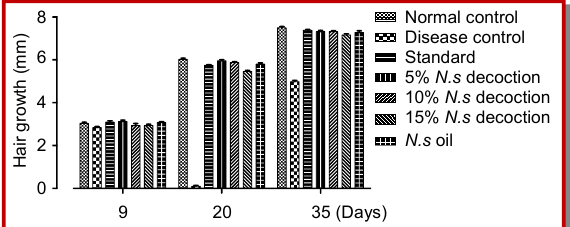
Figure 2: Hair growth (mm) in different groups on day 9, 20 and